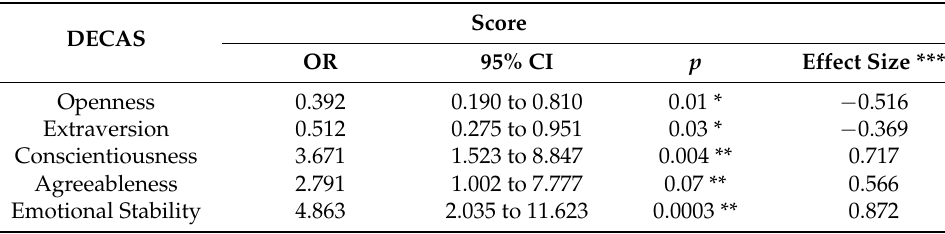
Table 2. Associations between personality dimensions and score.